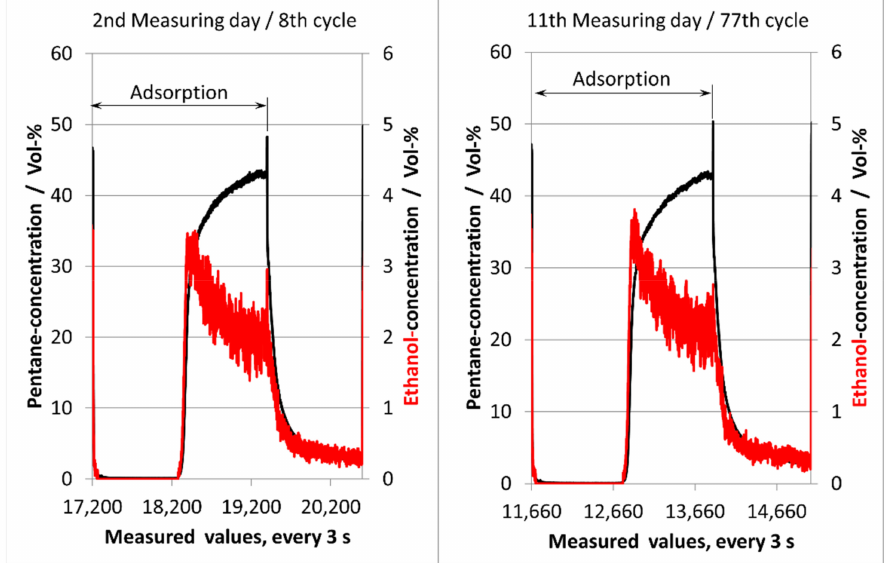
Figure 12. Breakthrough of ethanol for the system E10/dry N 2 in the 8th and 77th